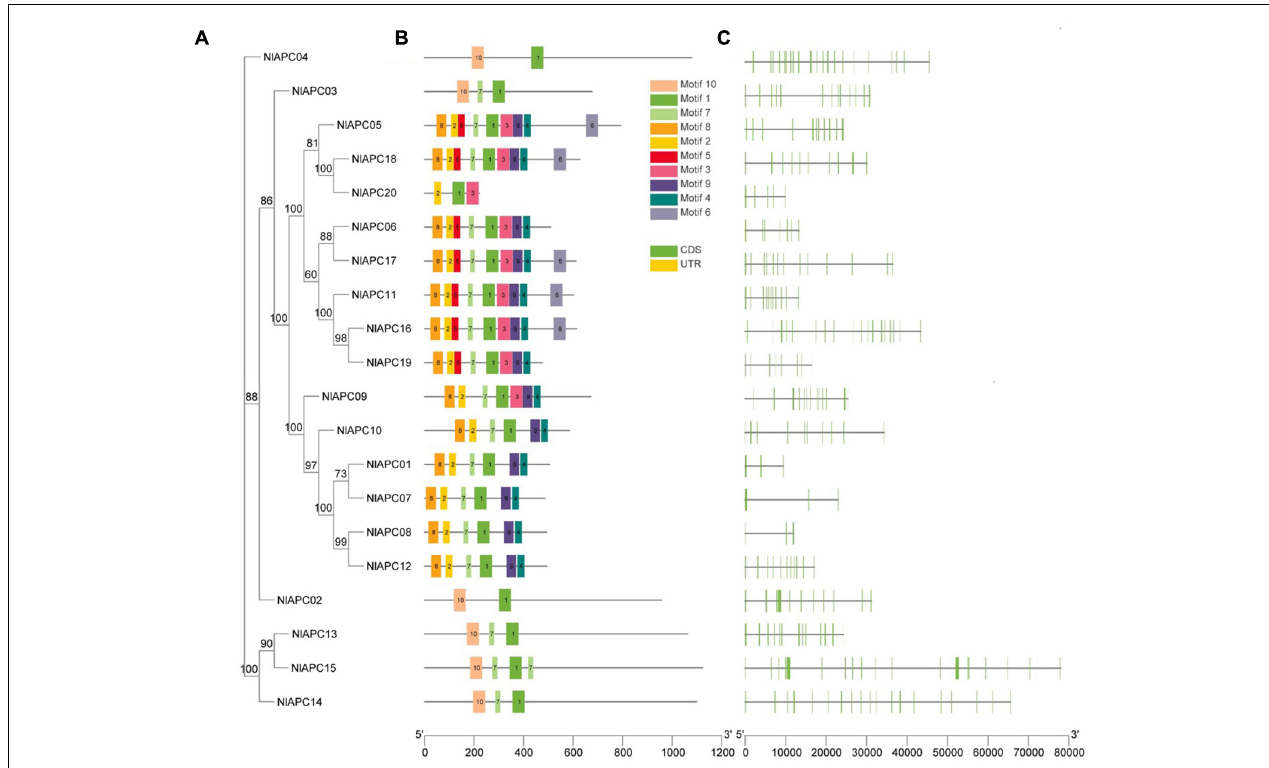
FIGURE 2 | Phylogenetic relationships, motif compositions, and gene structures of identified APC transporter genes from BPH. (A) Phylogenetic tree of 20 APC gene family members identified in BPH. The ML phylogenetic tree was built using IQ-Tree software version 2.0 based on the best-fit model of LG + G4, and bootstrap values shown on branches were calculated based on 1,000 replicates. (B) Conserved motifs contained by each BPH APC transporter protein. The conserved motifs were predicted by MEME Suite 5.5.3 and were presented by the boxes of different colors. (C) The exon-intron structure of each identified BPH APC transporter gene analyzed by TBtools v1.089. Yellow boxes, green boxes and black lines represent non-coding regions, exons, and introns, respectively.